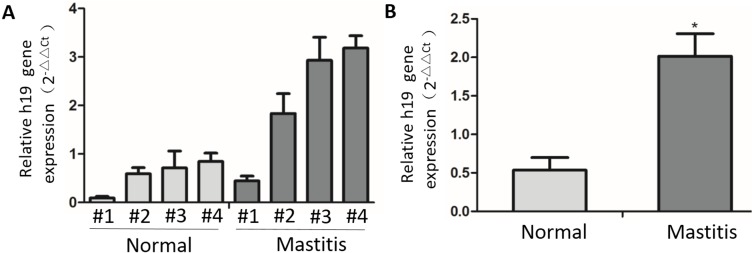
The expression of H19 in normal and mastitic tissue of bovine mammary glands.(A) Expression of the H19 gene in normal (n = 4) and mastitic (n = 4) tissue of mammary glands was assessed by RT-qPCR. GAPDH was used as an internal control. (B) Statistical analysis of the expression of H19 gene between normal and mastitis group. ∗p < 0.01 vs normal.